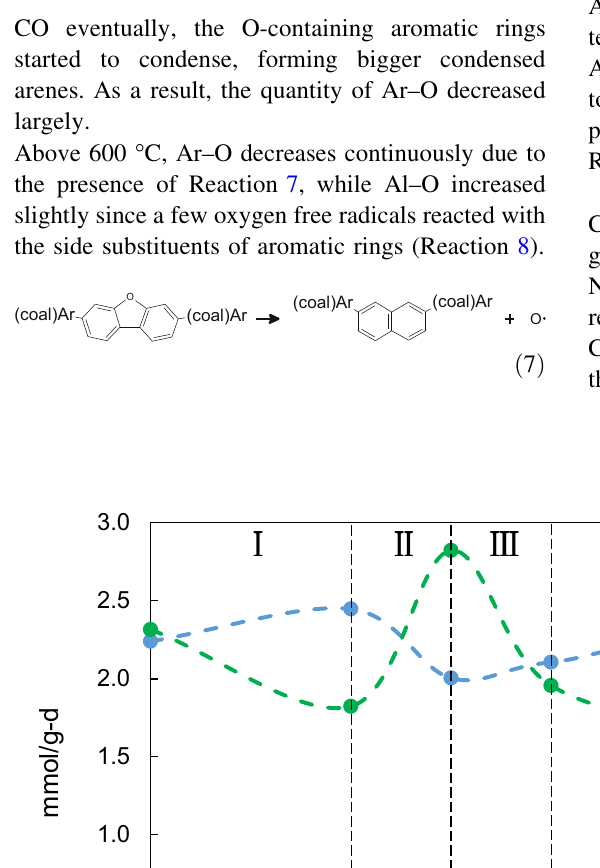
Fig. 4 Trends of bridgehead carbons as a function of temperature of coal NG and